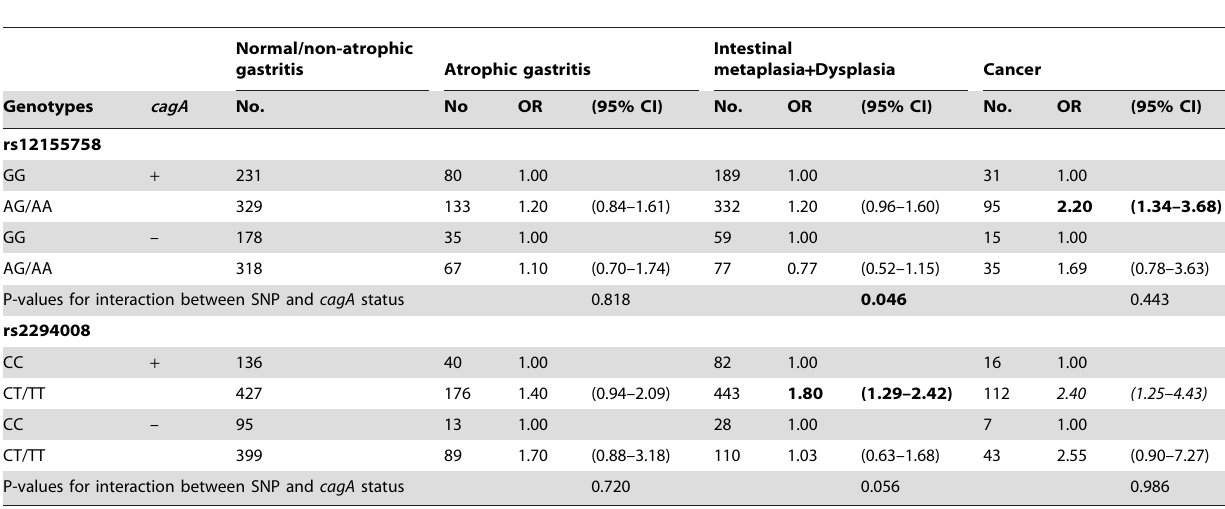
Table 4. ORs for pre-neoplastic lesions and gastric cancer cases stratified by diagnosis and cagA status, in comparison with normal or non-atrophic gastritis, according to individual PSCA